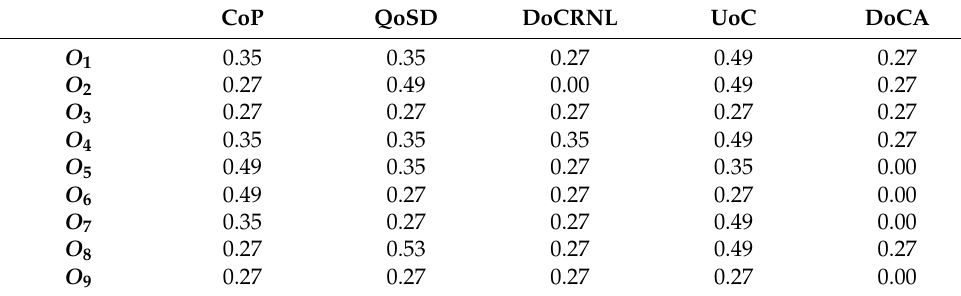
Table 25. Deviation values for PLTS ELECTRE